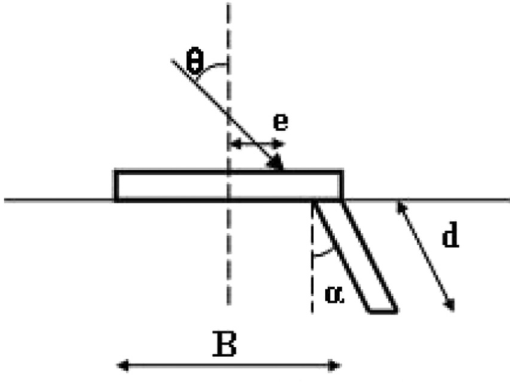
Figure 2: Parameters used in the analysis [ 15 ]